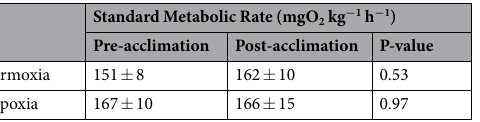
Table 1. Standard metabolic rate (SMR) of fish before and after a 14 day acclimation to normoxia and hypoxia. All data are means ± SEM. P-value is determined based on paired t-tests ( N = 7).